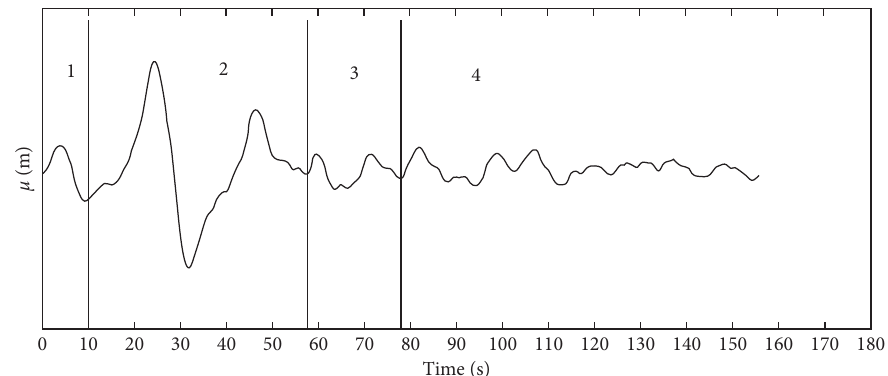
Figure 3: The displacement waveform of station